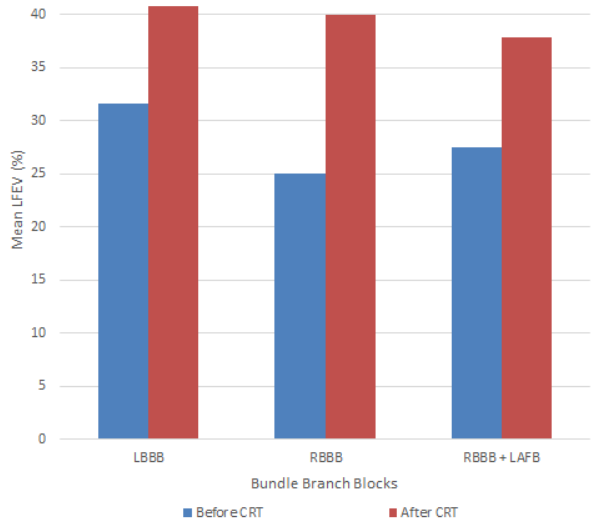
Fig. 1 – Mean left ventricular ejection fraction (LVEF) according to the bundle branch blocks presented by the patients before and after cardiac resynchronization therapy